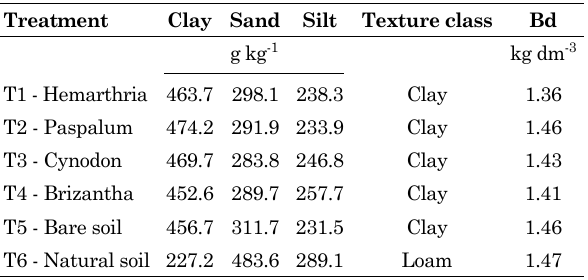
table 1. Particle-size fractions, texture class and bulk density (bd) in the 0.00-0.03 m layer